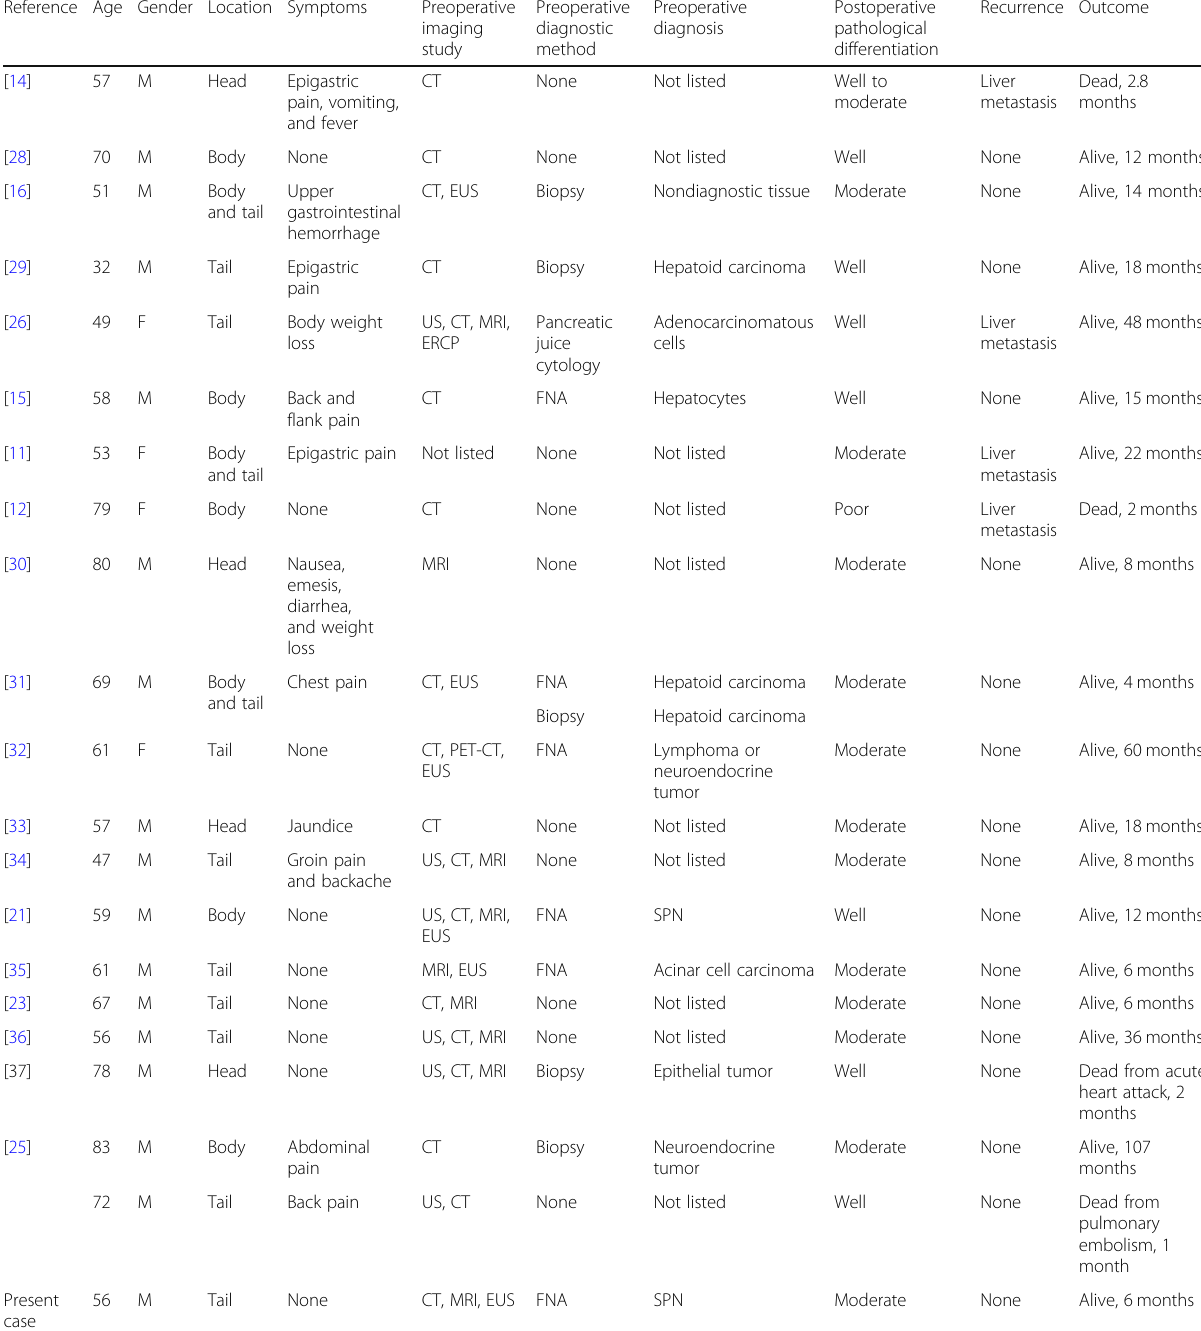
Table 1 Reported surgical cases of pure pancreatic hepatoid carcinoma in the literature Reference Age Gender Location